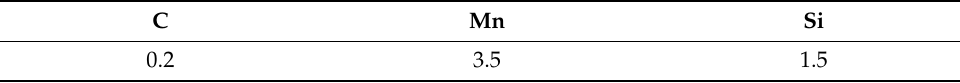
Table 1. Chemical composition (wt%) of the present